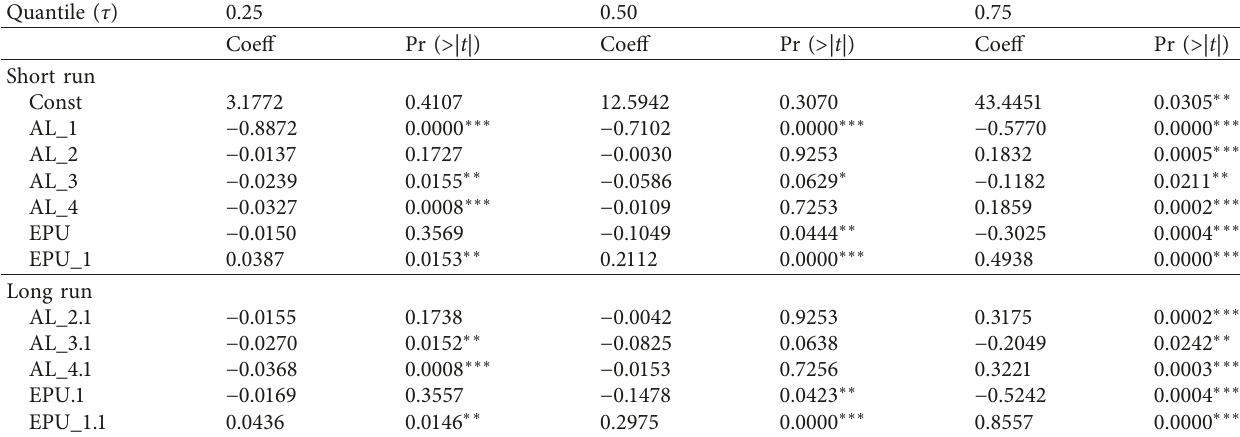
Table 9: QARDL estimation results: pandemic period (independent variable: